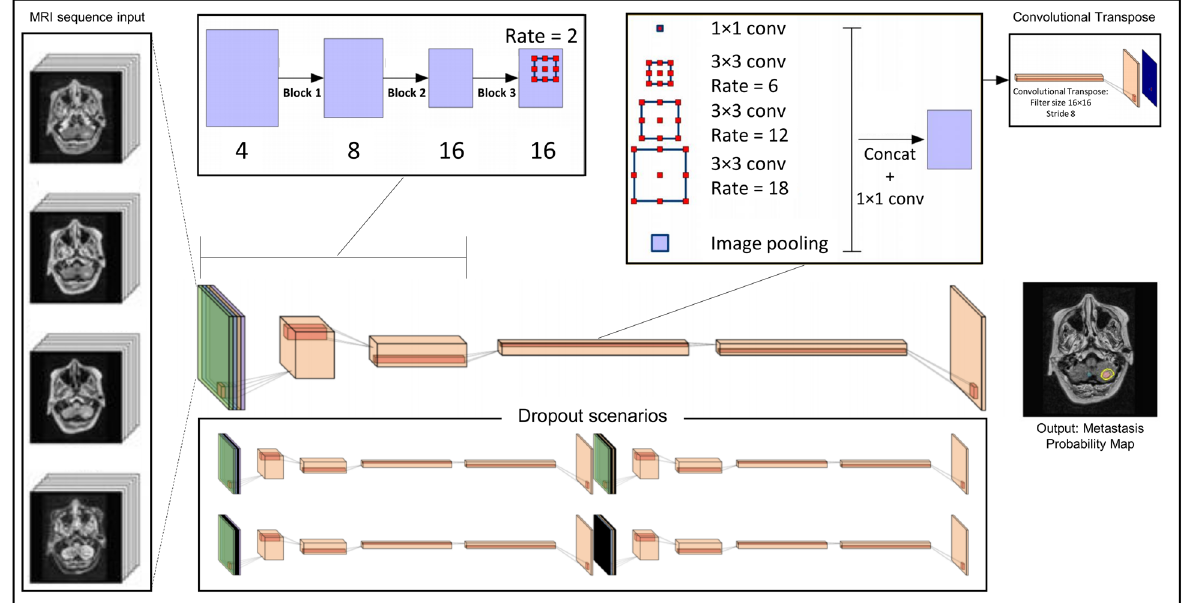
Fig. 4 Neural network architecture — Diagram showing the ILD-model architecture used in this study. Five contiguous axial slices of each of the four pulse sequences (BRAVO, pre-Gd and post-Gd CUBE, and T2-weighted FLAIR) are concatenated in the color-channel dimension to create an input tensor with channel dimension 20. This is fed into the neural network to predict the segmentation on the center slice. The pipeline is built largely on the DeepLab V3 architecture 21